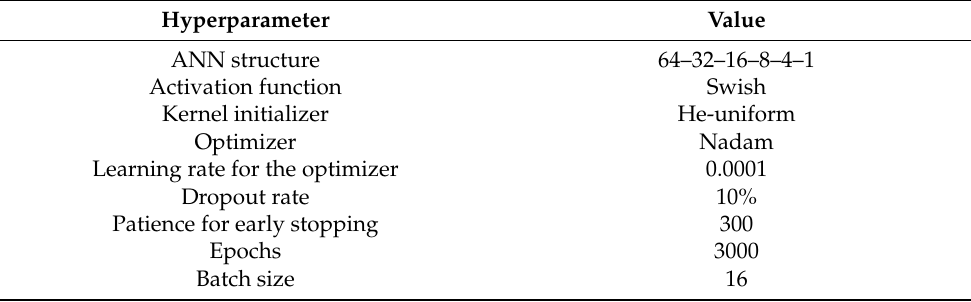
Figure 6. Example of the designed ANN with a structure of 64–32–16–8–4–1 layers. Table 7. Hyperparameters for the ANN